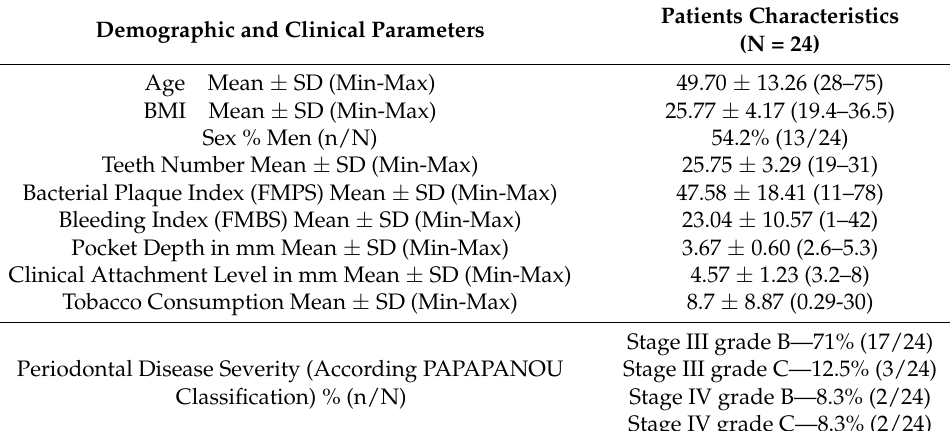
Table 1. Demographic and clinical data of the 24 included participants.